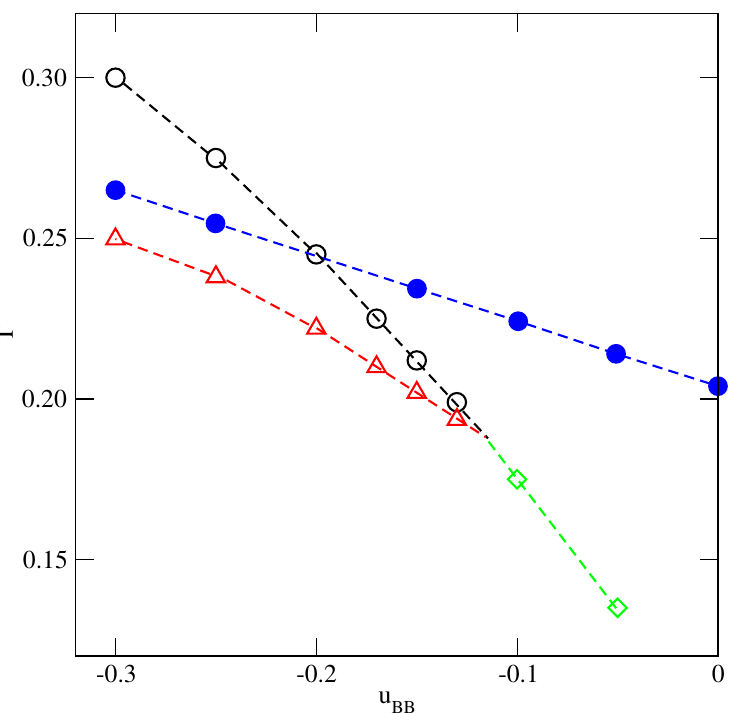
Figure 14. The changes of the critical temperature, T c ( u BB ) , (circles), the tricritical point temperatures, T trc ( u BB ) (diamonds), the critical end point temperatures, T cep ( u BB ) (squares), and the orientational order − disorder transition temperature in close-packed systems, T o ( u BB ) (filled circles), for the systems with u AB =